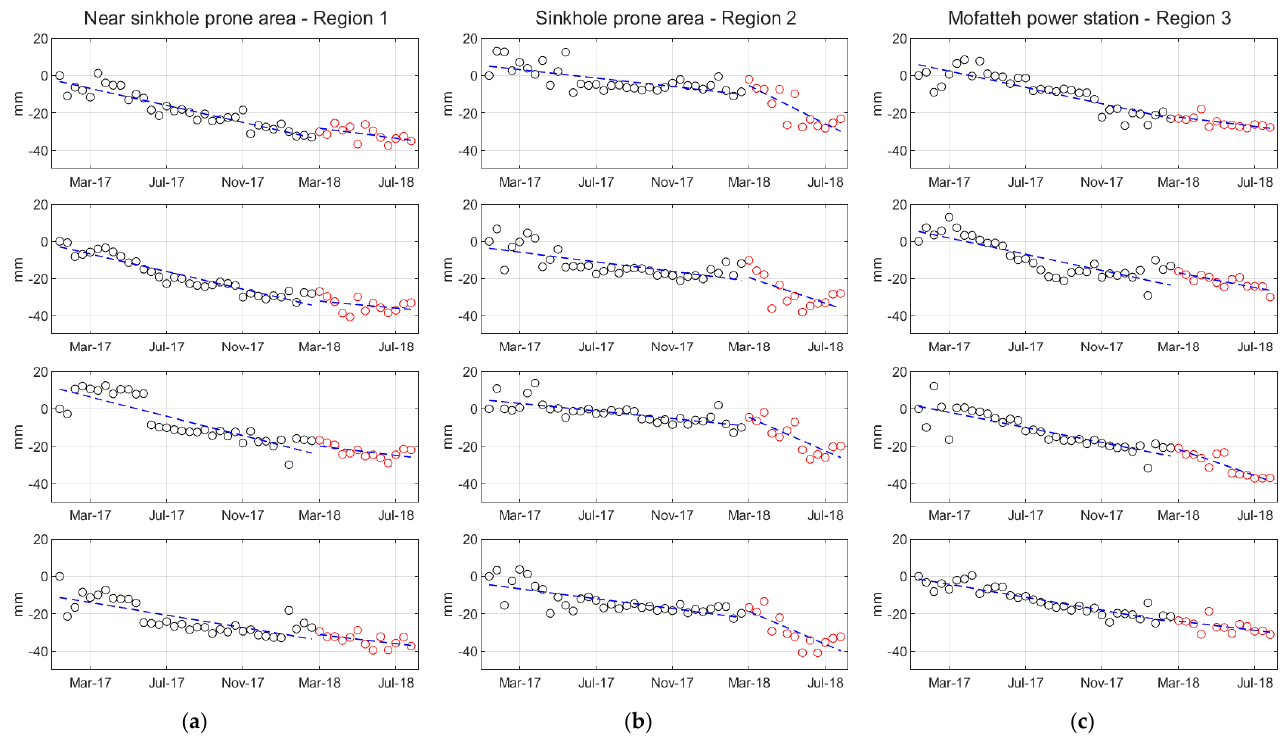
Figure 10. Temporal behavior of selected PSs in the regions, ( a ) near the cave area, ( b ) cave area, ( c ) near to the Mofatteh power plant.